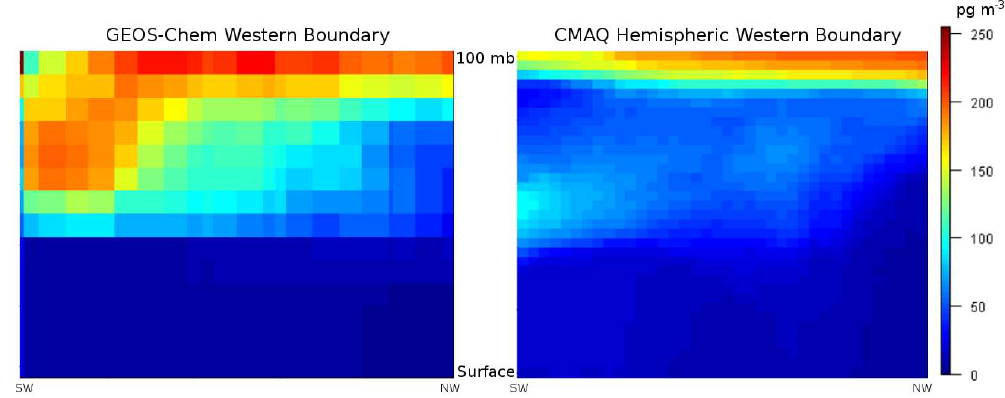
Fig. 4. Hg 2 + western boundary conditions from the GEOS-Chem and CMAQ hemispheric simulations for April 2005.